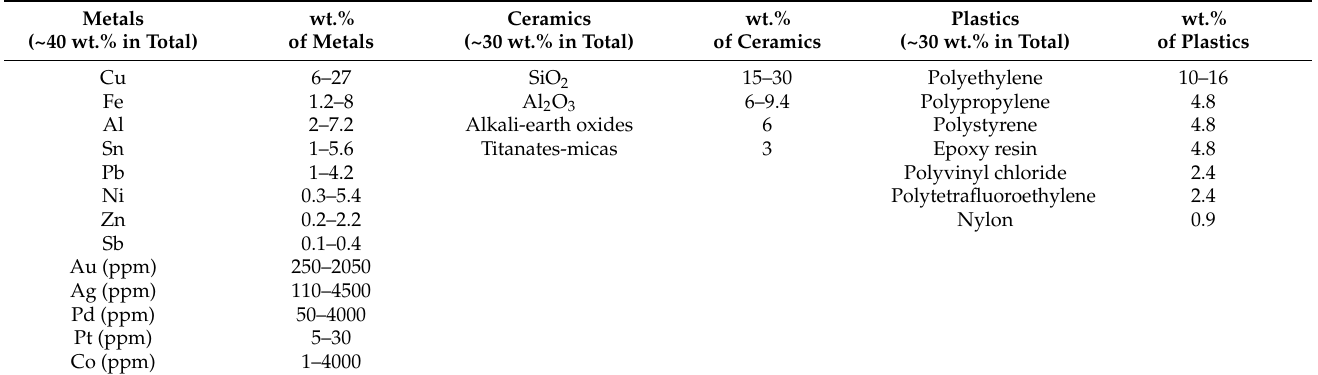
Table 1. Typical PCB composition attributed to the general groups of materials, data from